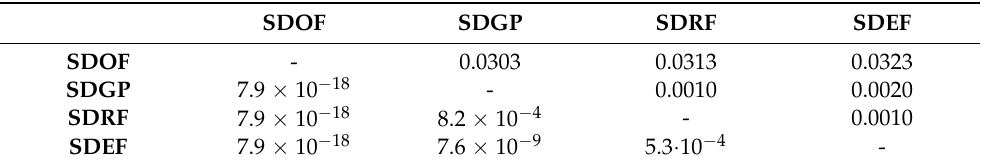
Table 6. To the right of the diagonal stand the estimated differences of RMSE between models for smoothed data. To the left of the diagonal stand the adjusted p -values for the H 0 (null hypothesis): difference = 0.